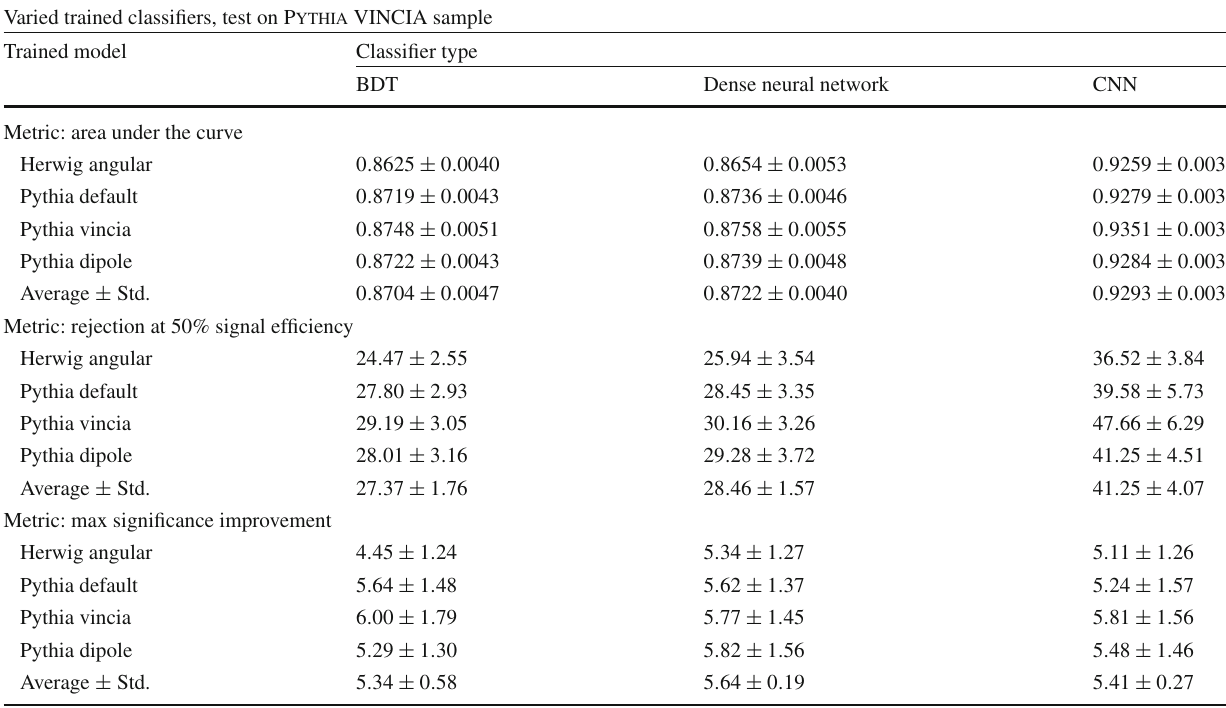
Table 3 Area under the curve, rejection at 50% signal efficiency and maximum significance improvement when testing on Pythia VINCIA for each trained classifier. The last rows are the average and standard deviation over the mean values from the other rows Varied trained classifiers, test on Pythia VINCIA sample